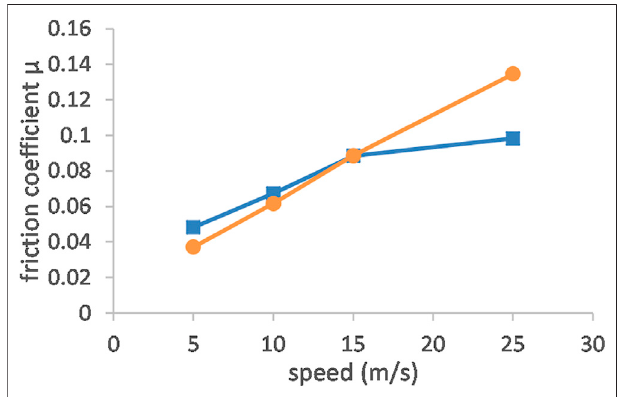
FIGURE 3 | Friction coef fi cient µ vs. speed of the XC ski (orange circles) and the fl at ski (blue